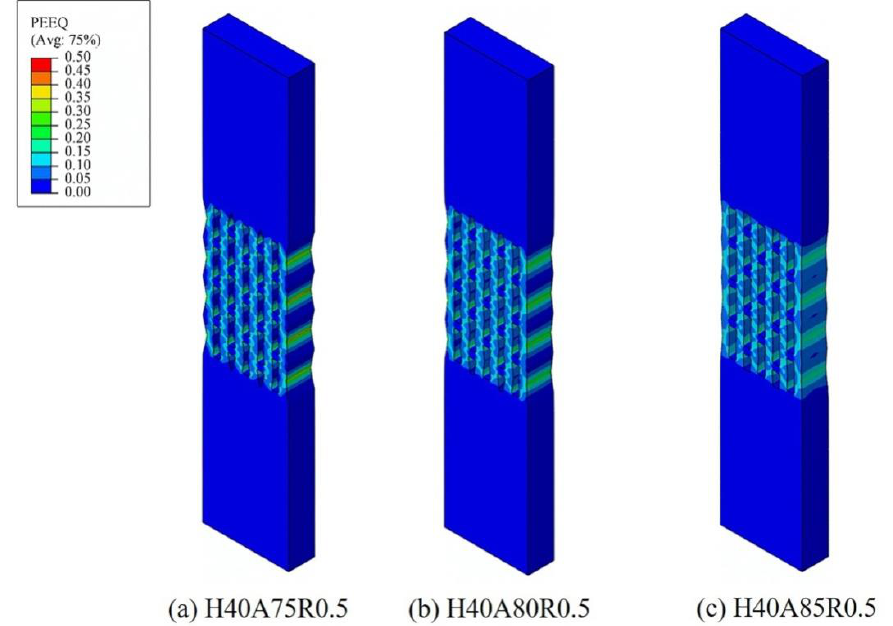
Figure 16. E ff ect of concave angle on equivalent plastic strain with ( a ) H40A75R0.5 ( b ) H40A80R0.5 Figure 16. Effect of concave angle on equivalent plastic strain with (a) H40A75R0.5 (b) H40A80R0.5 and ( c ) H40A85R0.5. Appl. Sci. 2020 , 10 , x FOR PEER REVIEW and (c)H40A85R0.5.